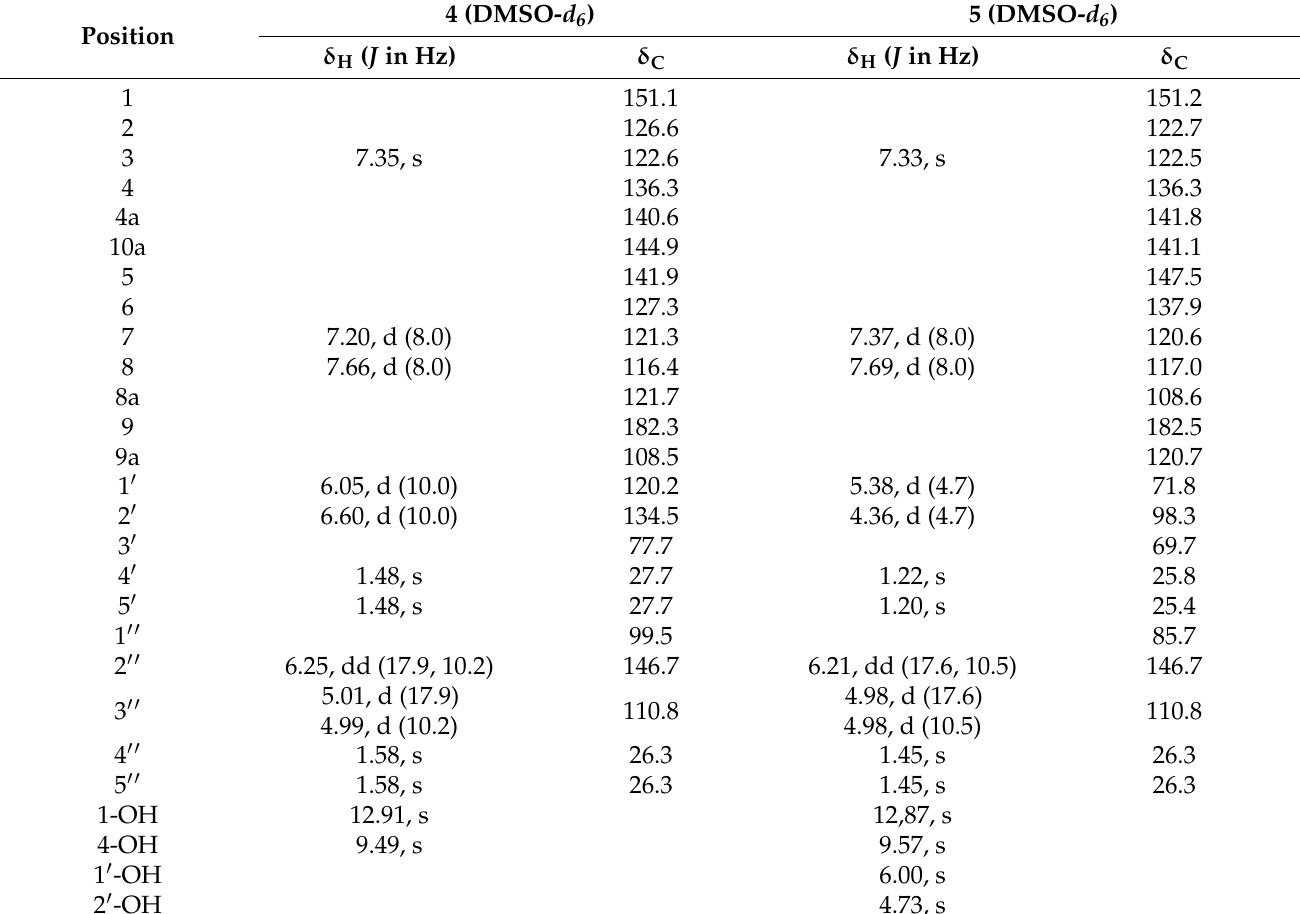
Table 2. 1 H (400 MHz) and 13 C (100 MHz) NMR of Compounds 4 – 5 (in